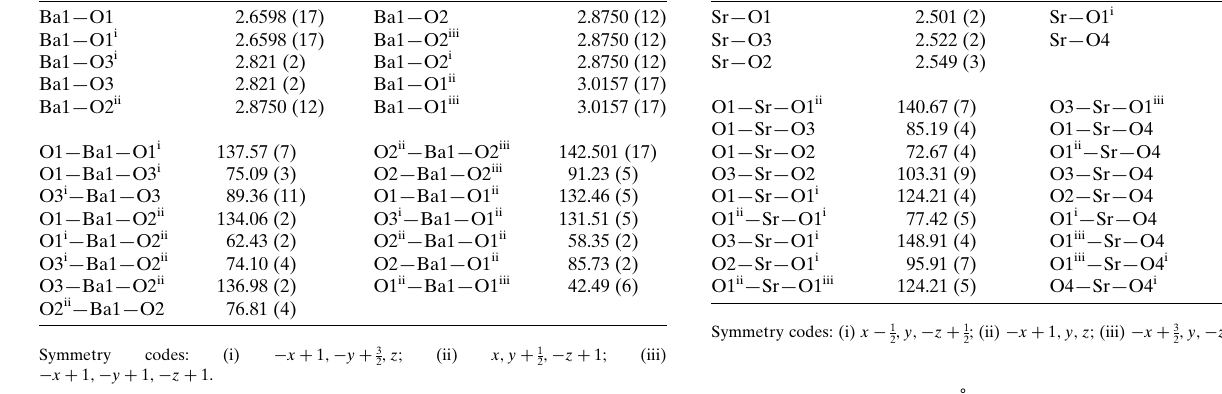
Table S1 in the supporting information). In (I), the barium cation is decacoordinated by four oxygen atoms from three ttzbenz ligands, two independent oxygen atoms from two terminal water molecules (O2 and O3) and four additional oxygens from bridging water molecules. In compound (II), the Sr 2+ ion is eightfold coordinated, being surrounded by four bridging water molecules and by four oxygen atoms from three symmetry-related ttzbenz ligands (Fig. 2), thus gener- ating a triangular dodecahedral SrO coordination geometry; 8